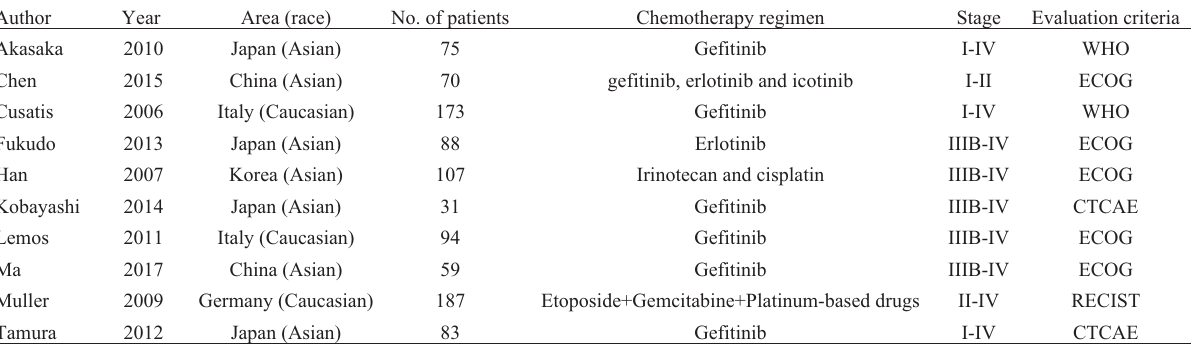
Table 1 - Characteristics of the included